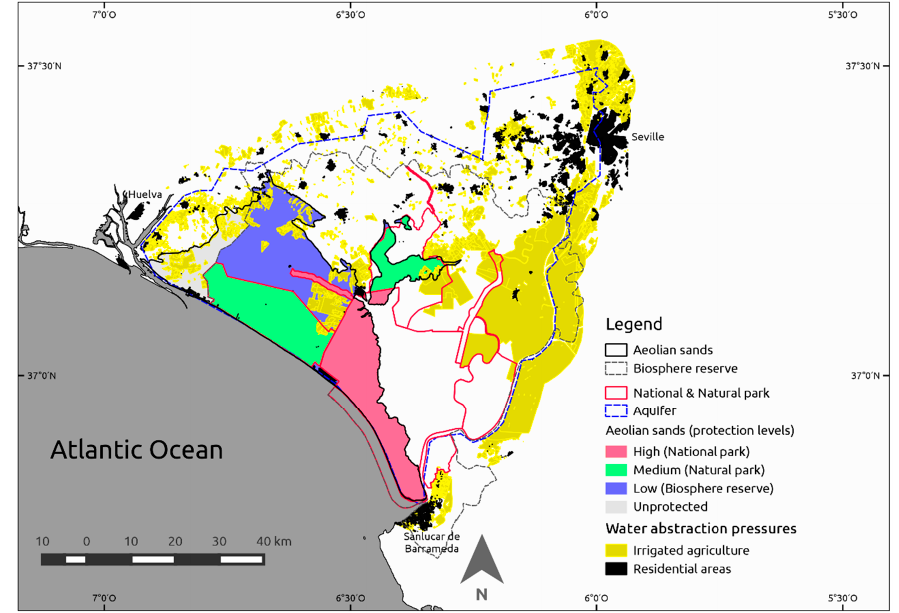
Figure 2. Distribution of water abstraction pressures in 2007 using a 5 km buffer on top of the “Almonte-Marismas” aquifer. Irrigated agriculture in yellow, residential areas in black. The other colored areas identify the Doñana’s aeolian sands with each color representing a level of protection. Lines indicate the limits of the “Almonte-Marismas” aquifer, Doñana National Park, Natural Park and Biosphere Reserve.